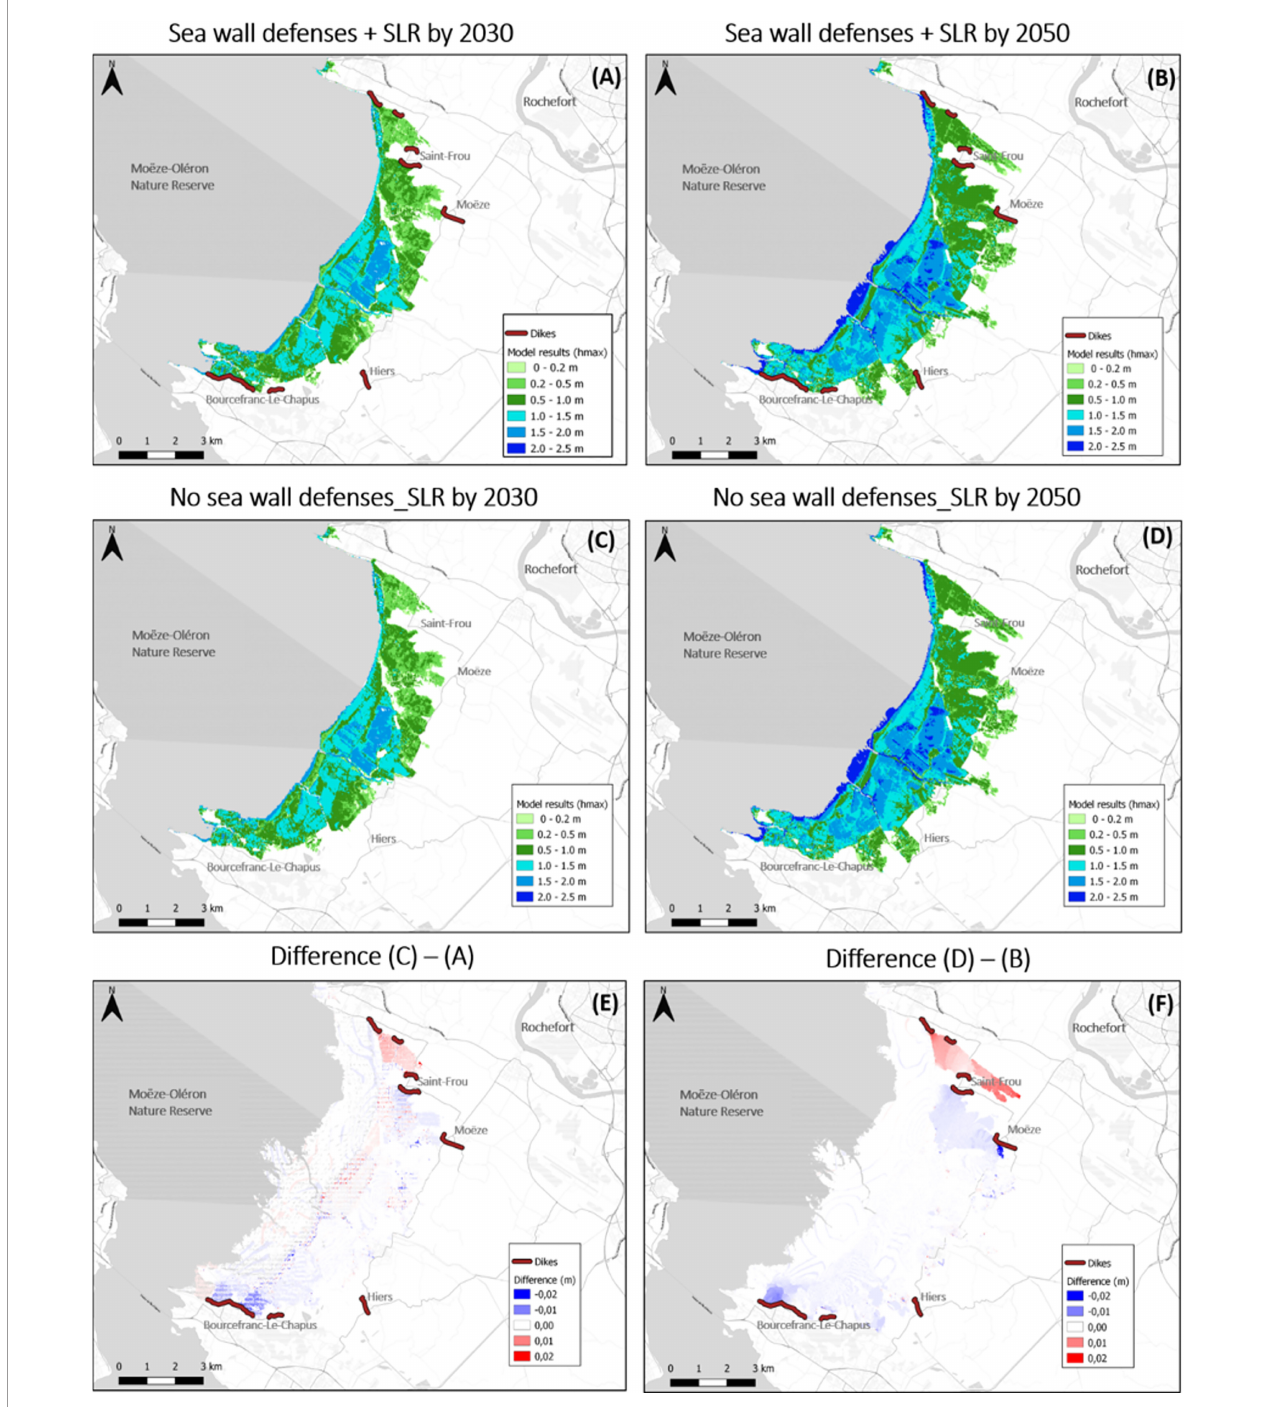
FIGURE 6 | Maximum heights simulated taking into account: (A) P3 _2030 scenario; (B) P3 _2050 scenario; (C) P4 _2030 scenario; (D) P4 _2050 scenario; (E) Difference P4 _2030 – P3 _2030 ; (F) Same as (E) by